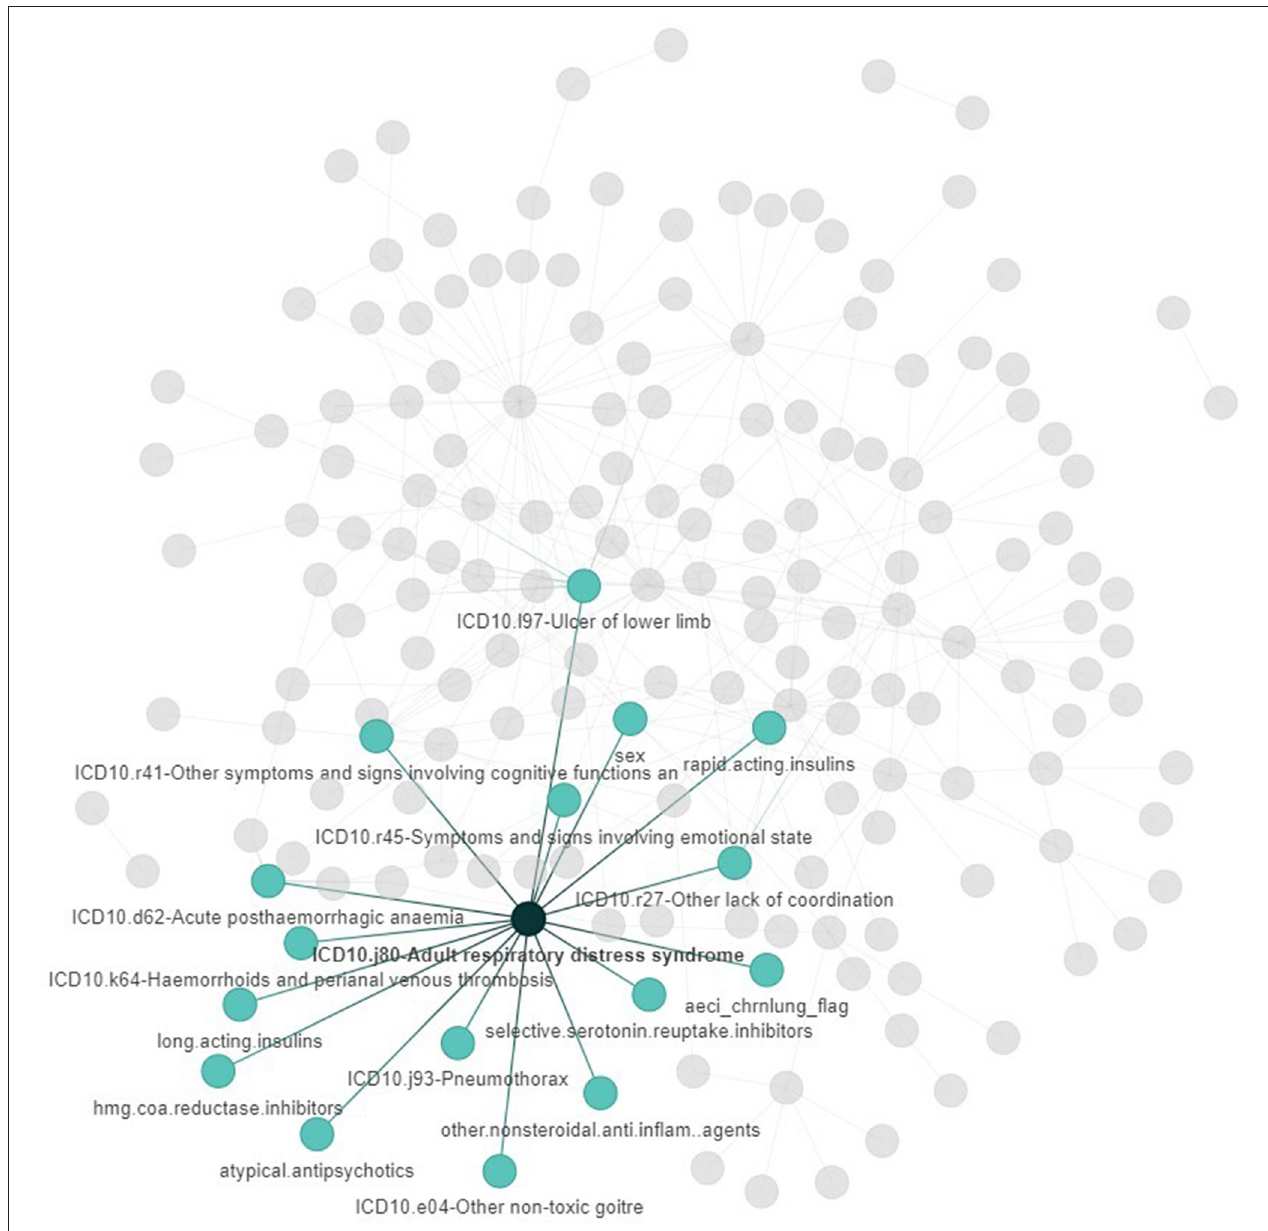
FIGURE 3 | The network architecture of filtered ( n = 255) disease signatures associated with hospitalized COVID-19 patients in Cohort 1 generated by the PrecisionLife platform where each circle represents a feature and edges represent co-association in patients. The colored nodes and edges represent the disease signatures of patients who developed ARDS (shown in a darker shade) in Cohort 1. The co-associated features are shown in a lighter shade.